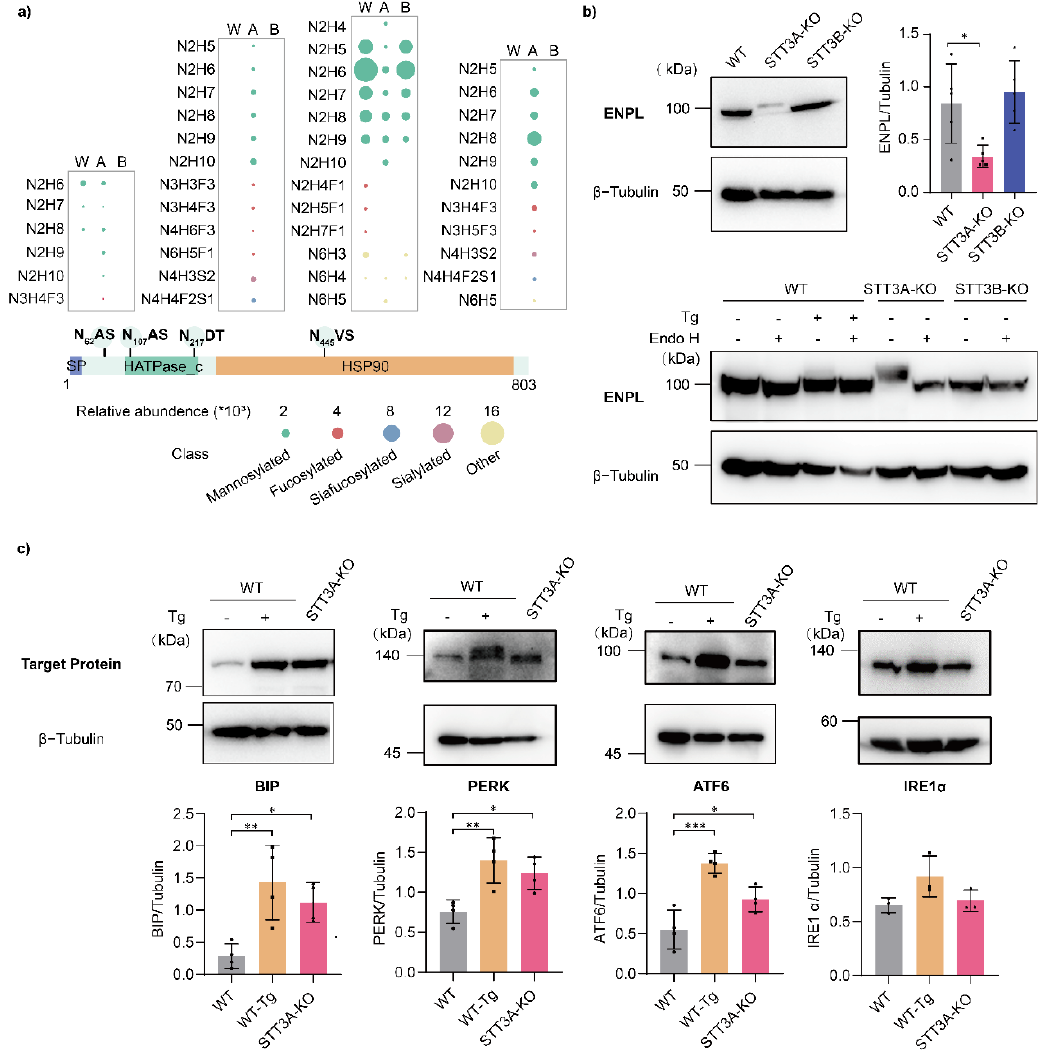
Figure 6. IGP analysis and biological verification in WT and KO cells. ( a ) IGP analysis of ENPL. The size of bubbles represents the relative abundance, and the color represents the type of glycan. ( b ) Western blotting of ENPL in WT and KO cells. Thapsigargin (Tg) treatment: 100 nM for 24 h. Endo H treatment for 1 h. W: WT; A: STT3A-KO; B: STT3B-KO. ( c ) Expression of BIP, PERK, IRE1 α , and ATF6 in WT cells with or without thapsigargin (Tg) (100 nM for 24 h) and STT3A-KO cells was detected using immunoblotting. β -Tubulin was used as a loading control. ***, p -value < 0.001; **, p -value < 0.01; *, p -value < 0.05.